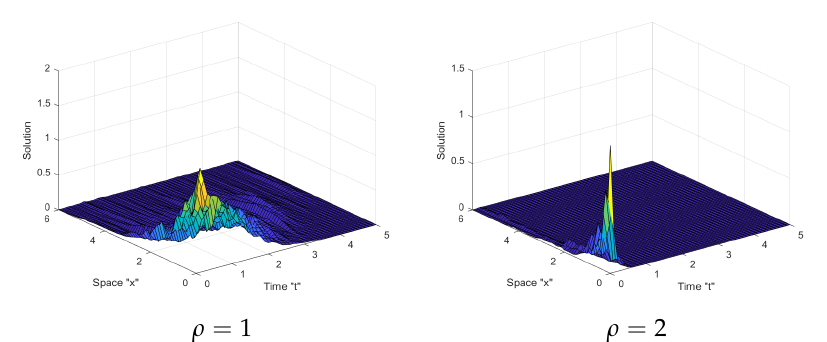
Figure 1. Three-dimensional (3D) plots of the solution (48) with α = 1.